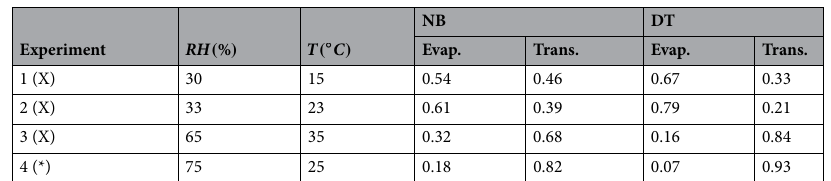
Table 3. Results of regime estimation for four experiments under new conditions unseen by the model. The true regime of each experiment is shown on the regime map in Fig. 1b.